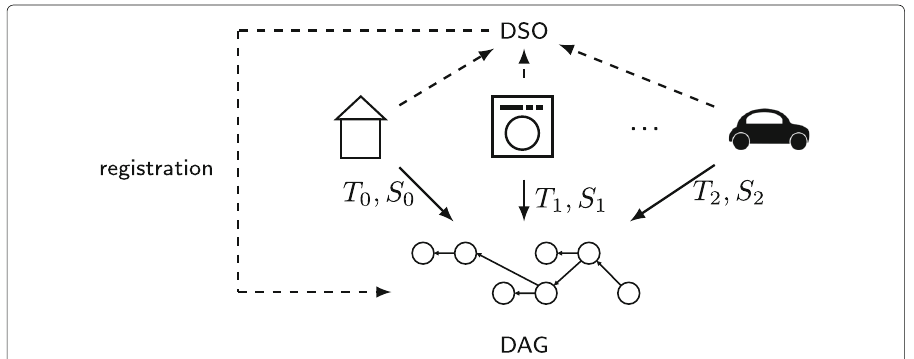
Fig. 3 Overview of the proposed protocol and the communication links. Participants (e.g., households, appliances and EVs) register at the DSO and then commit their load forecasts to the DAG